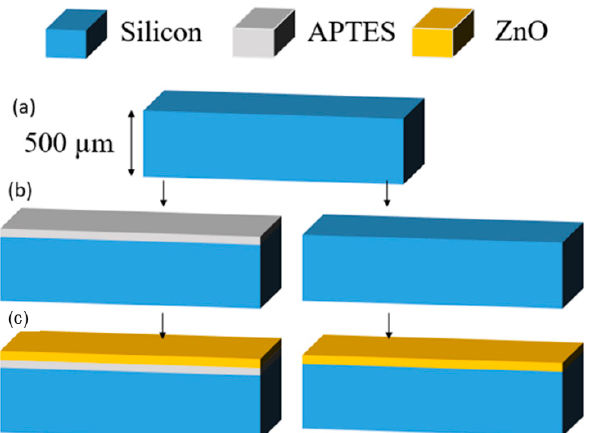
Figure 3. Three fabrication steps ( a – c ) from cleaning to depositing ZnO NPs by electrophoretic deposition.